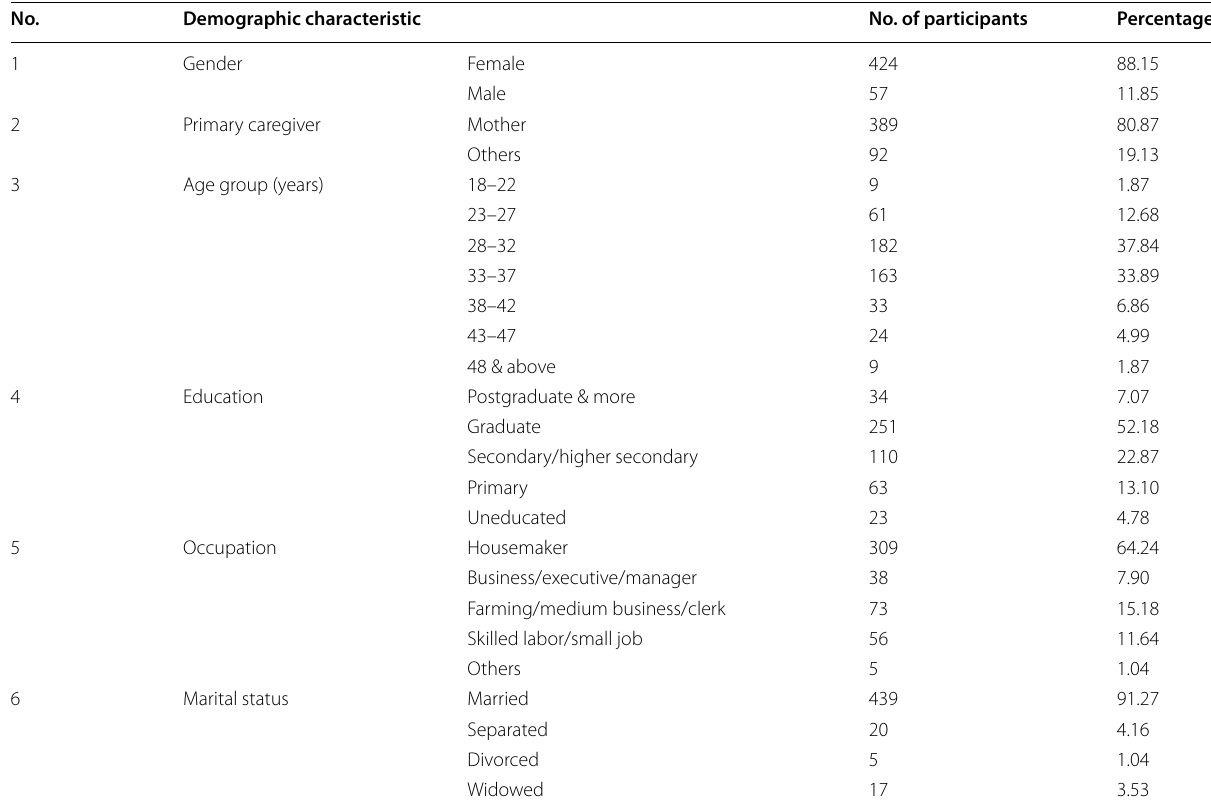
Table 2 Demographic characteristics of caregivers of CP children No.